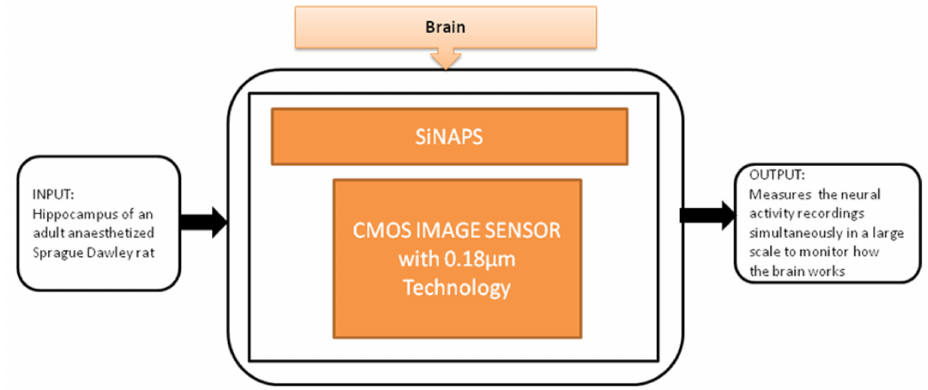
Figure 21. Simultaneous large scale neural recording SiNAPS probe for in vivo neuroscience research.